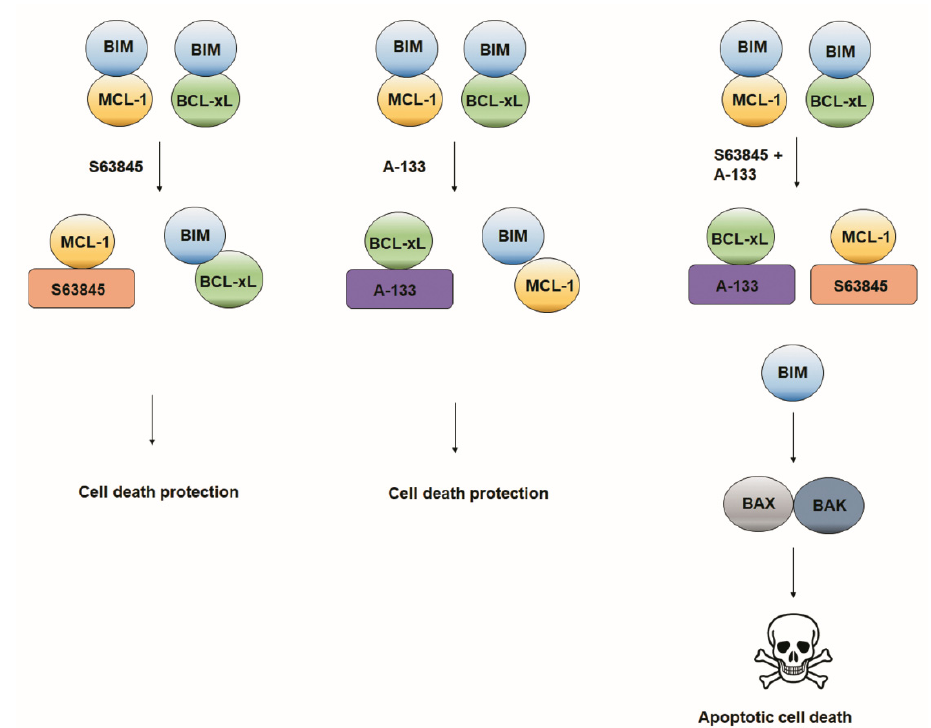
Figure 5. Schematic representation of MCL-1 and BCL-xL interaction with BIM as a therapy-acquired resistance mechanism. The model distinguishing mechanisms that may operate in the presence of either S63845, A-133, or the sequential combination of both BH3 mimetics. The interaction of BIM with MCL-1 and A-133 would shift depending on the BH3 mimetic used, conferring cell death protection. Only when we sequentially combined both BH3 mimetics, cells will undergo apoptotic cell death.